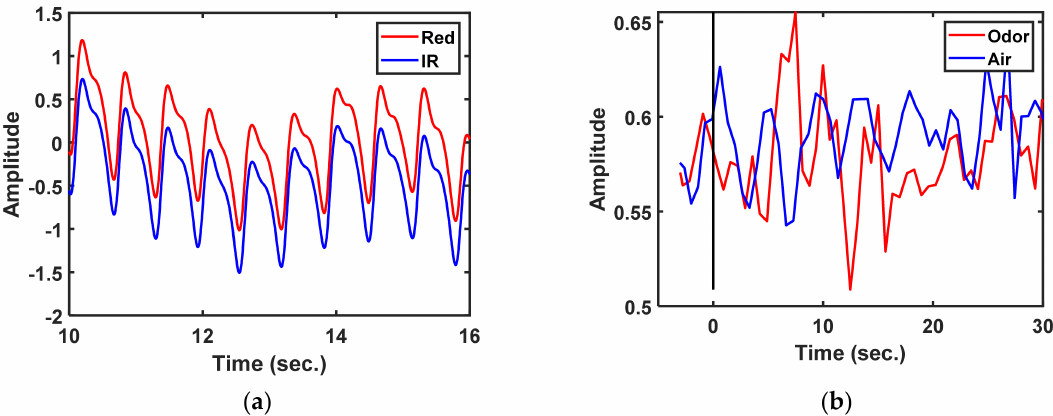
Figure 4. Functional near-infrared spectroscopy measurement of the prefrontal cortex: ( a ) raw photoplethysmography (PPG) PPG-R and PPG-IR signals, ( b ) 33 s block data in which the dbRatio waveforms have an odor and air